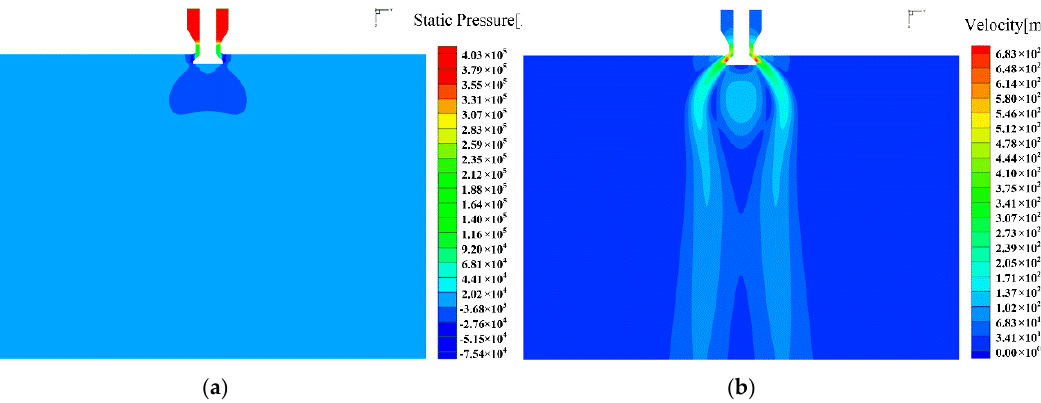
Figure 9. The outflow pressure and velocity contour of the type B push-open injector. ( a ) Static pressure contour; ( b ) Velocity contour (inlet pressure 4bar).